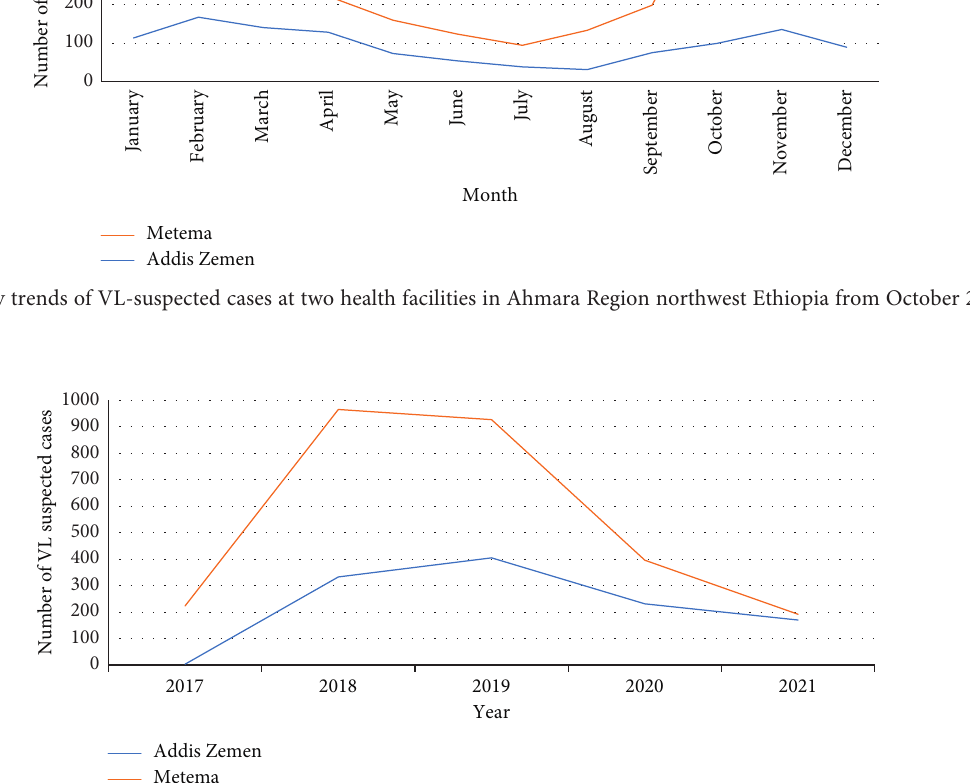
Figure 3: A 4-year and 7-month trend of VL-suspected cases at two health facilities in Ahmara Region northwest Ethiopia from October 2017 to May